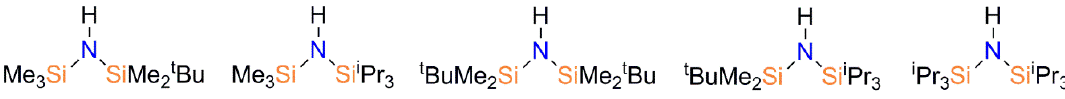
Figure 1. The bulky bis(silyl)amines utilized herein (l-r): {HN(SiMe 2t Bu)(SiMe 3 )}, {HN(Si i Pr 3 )(SiMe 3 )}, {HN(SiMe 2t Bu) 2 }, {HN(SiPr i3 )(SiMe 2t Bu)} and {HN(SiPr i3 ) 2 } ( 1 ).